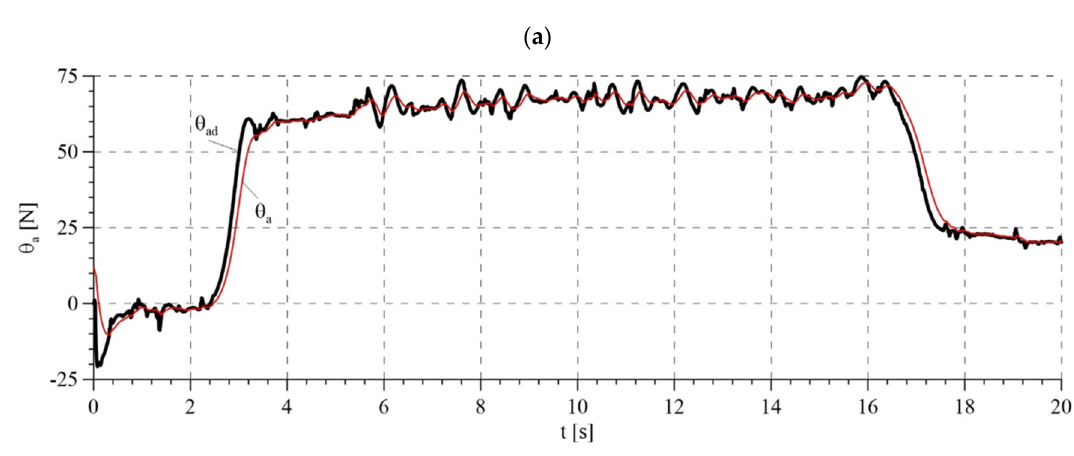
Figure 13. Trajectory of the active part of the system: ( a ) for the algorithm based on the mathematical model; ( b ) for the adaptive algorithm.